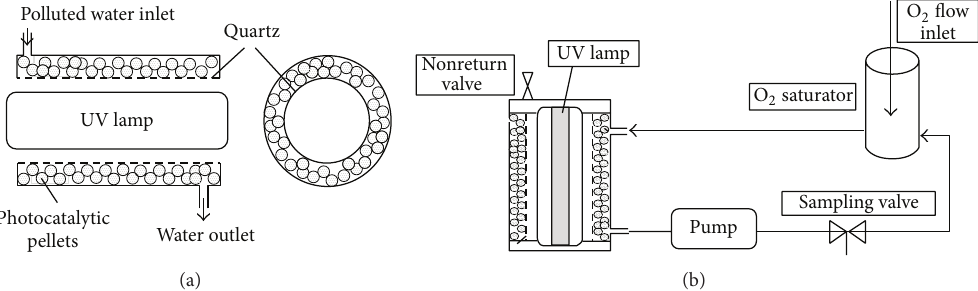
Figure 1: (a) Scheme of the photoreactor and the arrangement of the porous TS pellets (lateral and vertical cross-section views). (b) Schematic view of the photocatalytic